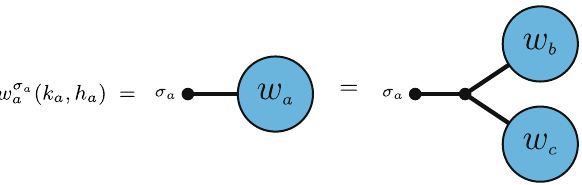
Fig. 1 Diagrammaticrepresentationofasubtreeanditsnumericalcon- structionthrough therecurrencerelation (18). The outgoing momentum k a andthespinorLorentzindex σ a areassociatedwiththeoff-shellinter- nal line, which is shown explicitly, while the on-shell external particles with helicity h a are implicitly understood